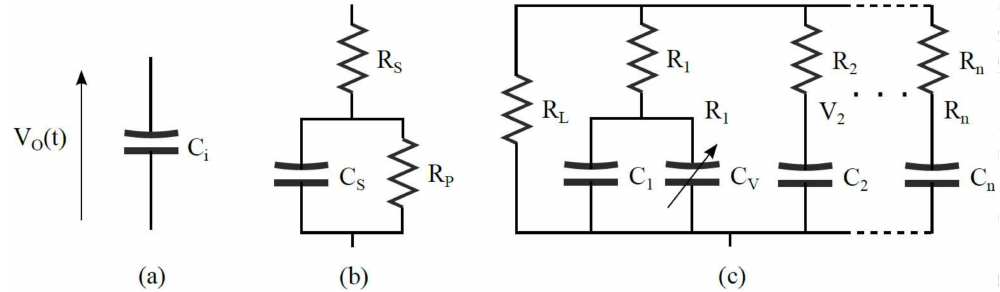
Figure 2. Circuit-based supercapacitor models: ( a ) an ideal capacitor. ( b ) Simplified model including a series and parallel resistance. ( c ) RC ladder circuit with a voltage-dependent capacitance in its first branch, which may be extended to n